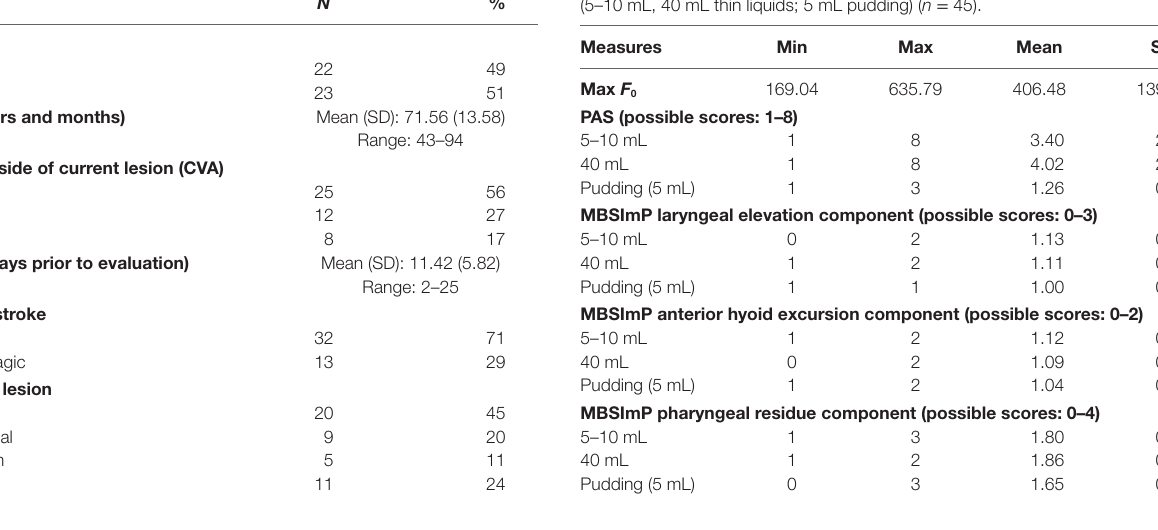
TaBle 2 | Descriptive statistics on maximum fundamental frequency (max